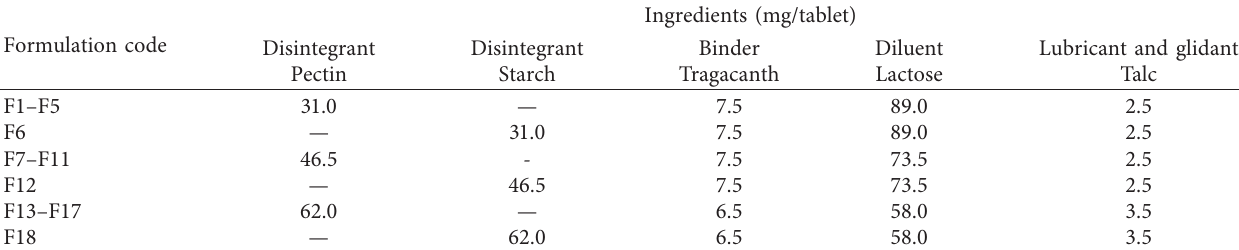
Table 1: Composition of formulated batches.